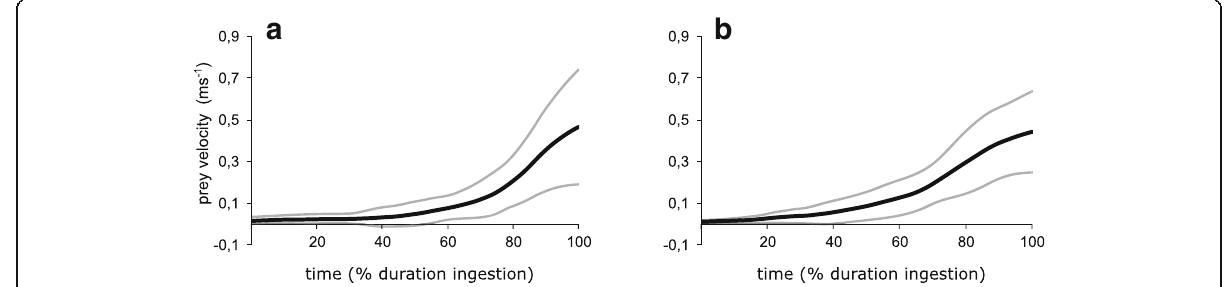
Fig. 4 Velocity of prey movements towards the Alpine newt ’ s mouth, induced by suction ( a metamorphs; b paedomorphs). The X-axes are normalized to the duration of prey ingestion, i.e. the time from the first prey movement towards the newt until prey disappeared in the